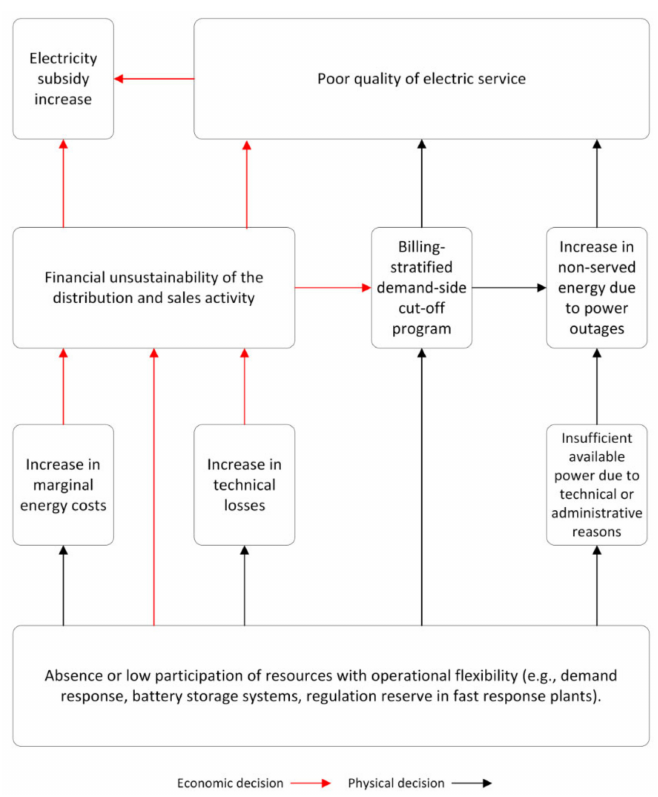
Figure 8. Causes of operational inflexibility and effects on